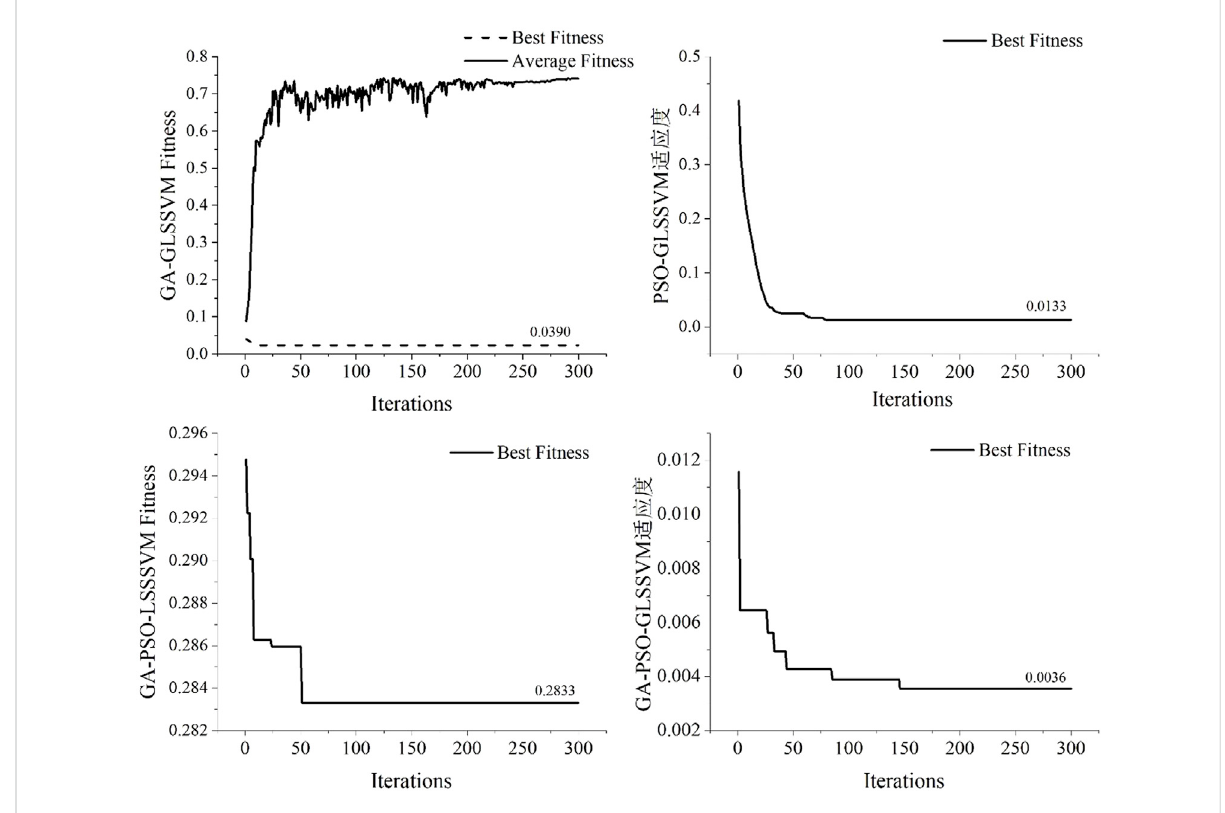
FIGURE 8 The fi tness changes of different algorithms.